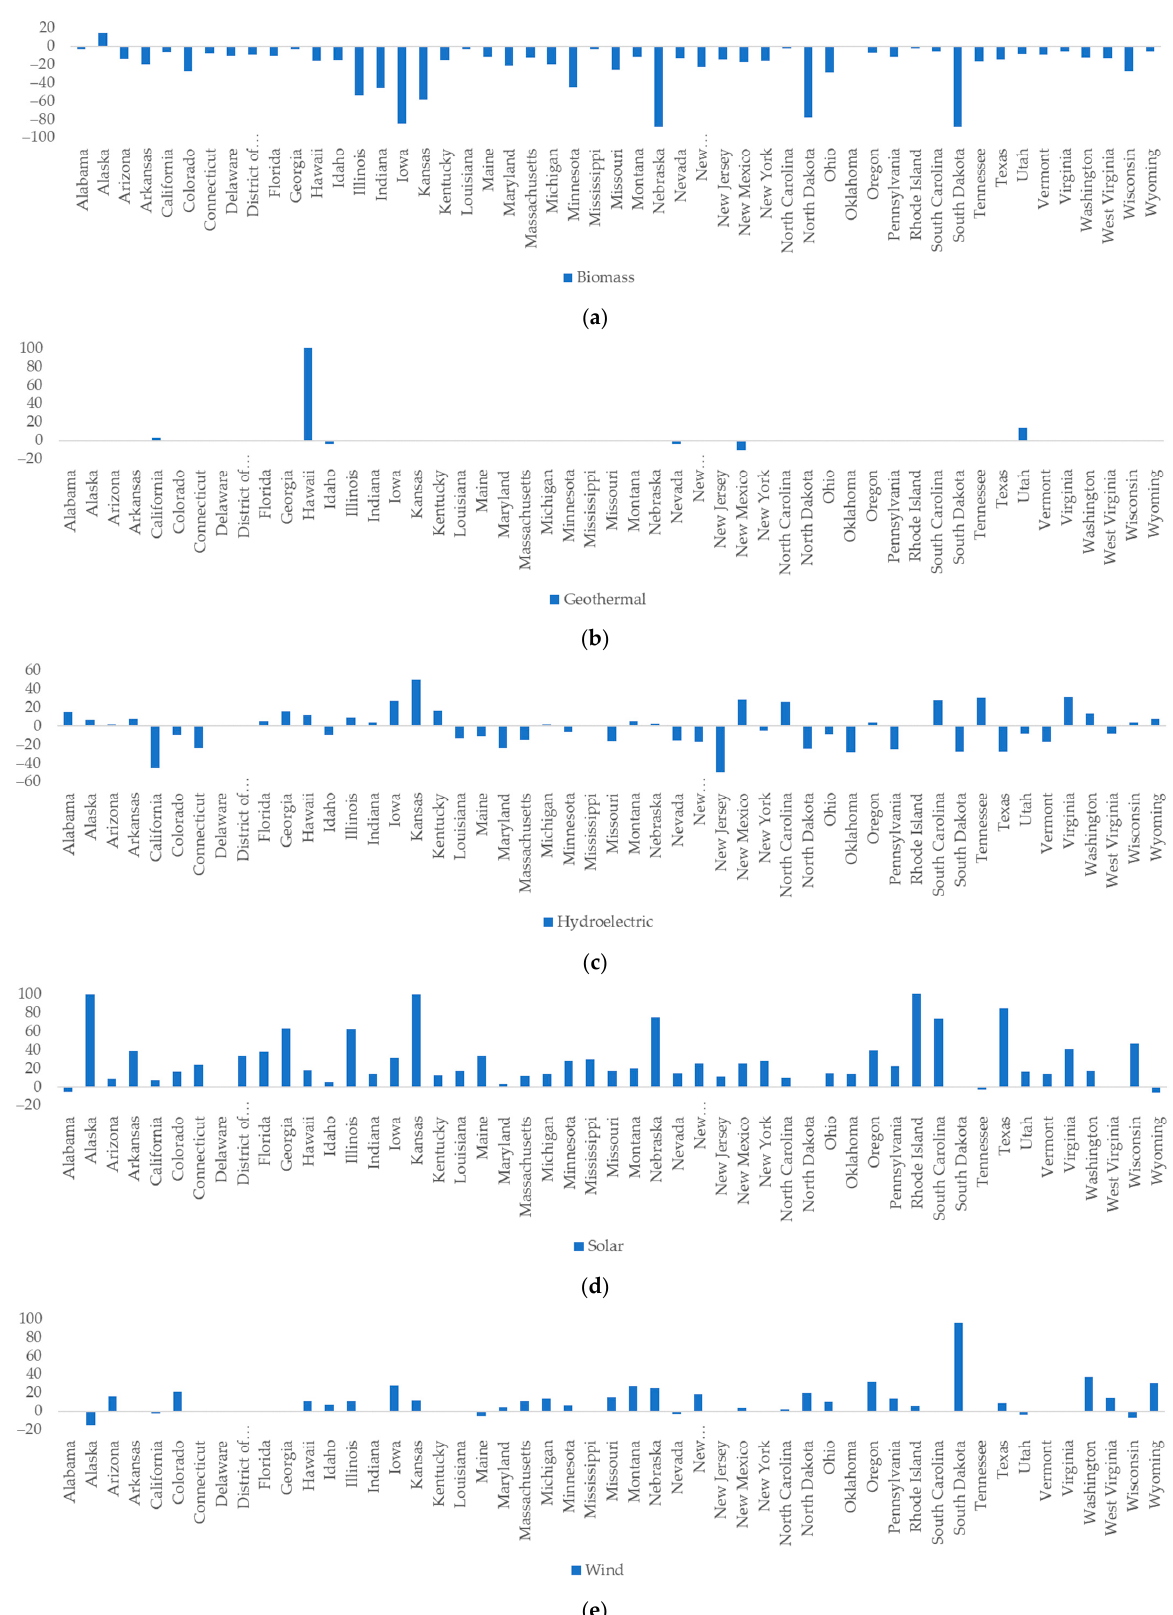
Figure 12. The 2019–2020 change (%) in renewable energy generation by state [30]. Figure 13 shows the final major component of US energy: total nuclear energy gen- eration from 2018 to 2020. Not every state has nuclear power plants, so only total genera- tion is shown. The capacity factor of the nuclear power industry averages about 90–93%. France, which is considered a world leader in nuclear power, hovers around 77%. As such, the data seen in Figure 13 are very close to the maximum generation capacity. As the ca- pacity plot indicates, total nuclear generation has gradually fallen as the US decommis- sions aging nuclear plants. Correspondingly, total energy generation has fallen. The en- ergy production in December 2020 was 4.7% lower than in January 2020. The generation plot shows some seasonal fluctuations. While nuclear plants operate as base load plants, there is some momentum on the concept of flexible nuclear operation. However, the his- toric data shown in Figure 13 simply show the two seasonal peaks, much like the coal and natural gas plots in Figure 11. Besides minor seasonal variations, the effect of refueling and plant maintenance outages also plays a part. The pandemic did not have any appre- ciable impact on the nuclear sector. Finally, it is important to note that the peak-to-trough variation in a year is about 20%, whereas it is about 50% for natural gas. Figure 13. US nuclear energy generation 2018–2020 [30]. Figure 14 shows the historic greenhouse gas emissions for the US from 2010 to 2020. The top three pollutants are shows: carbon dioxide, methane, and nitrous oxide. From Figure 14a, the general trend that can be noted is that emissions have trended downward. Carbon dioxide emissions fell by about 7.5% between 2010 and 2019. Just the next year, they fell by 10.4%, keeping in line with the general fall in energy consumption in the coun- try. Given that electricity and transportation account for 70% of carbon emissions, and considering that each fell by 2.5% and 7.5%, respectively, the 10.4% drop is understanda- ble. Similarly, methane fell by 5.2% between 2010 and 2019, an average of 0.5% per year. The following year, the drop was 2.8%. The top two sources of methane emissions in the